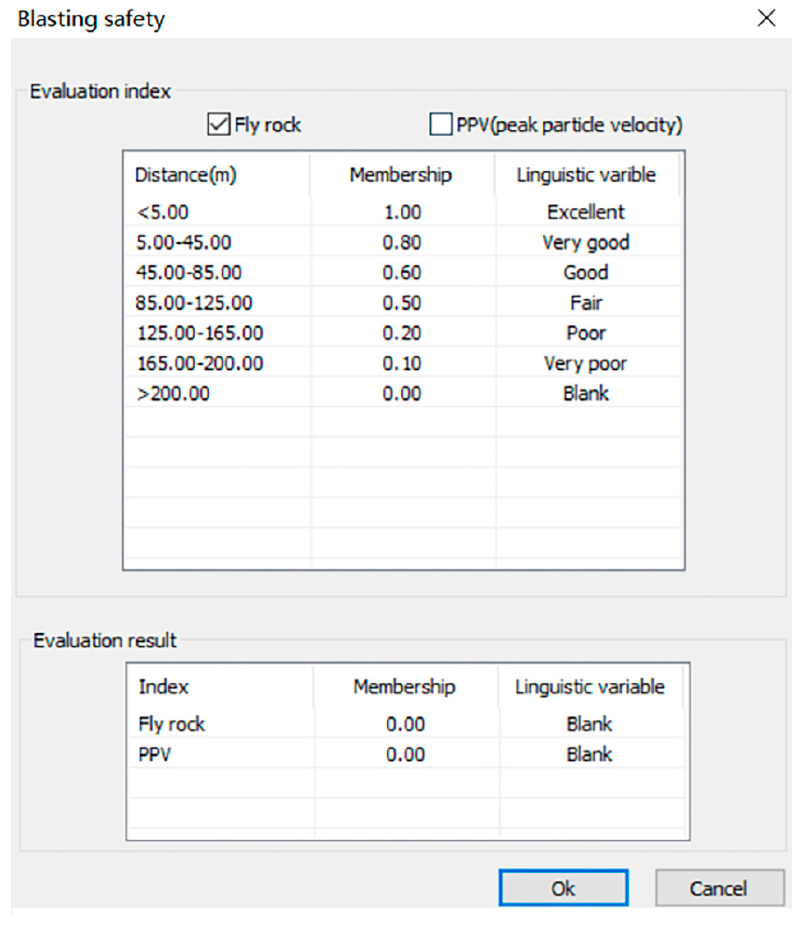
Figure 4. The evaluation result of each index.